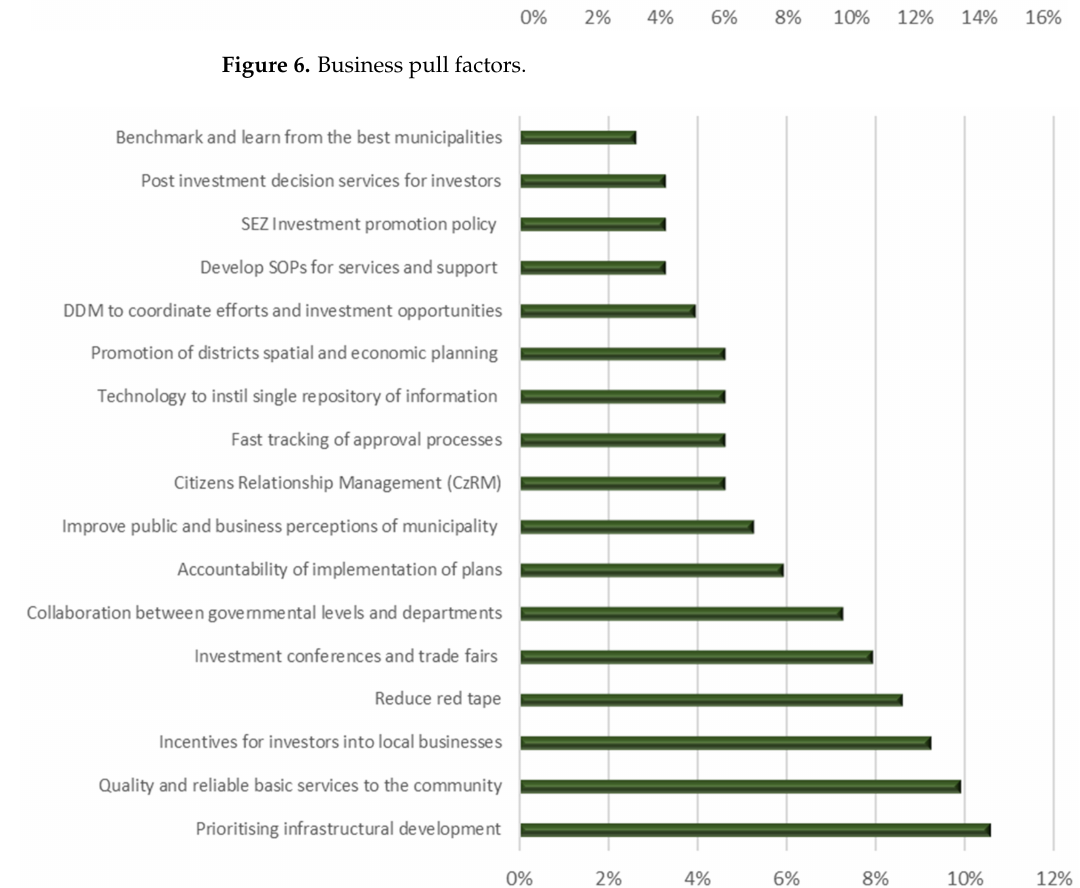
Figure 7. Key recommendations for business